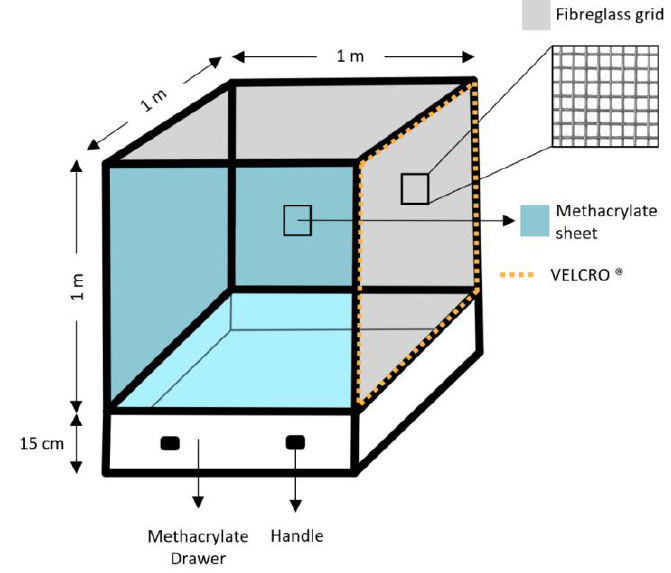
Figure 3. Scheme of the cage used for the captivity study of Vespa